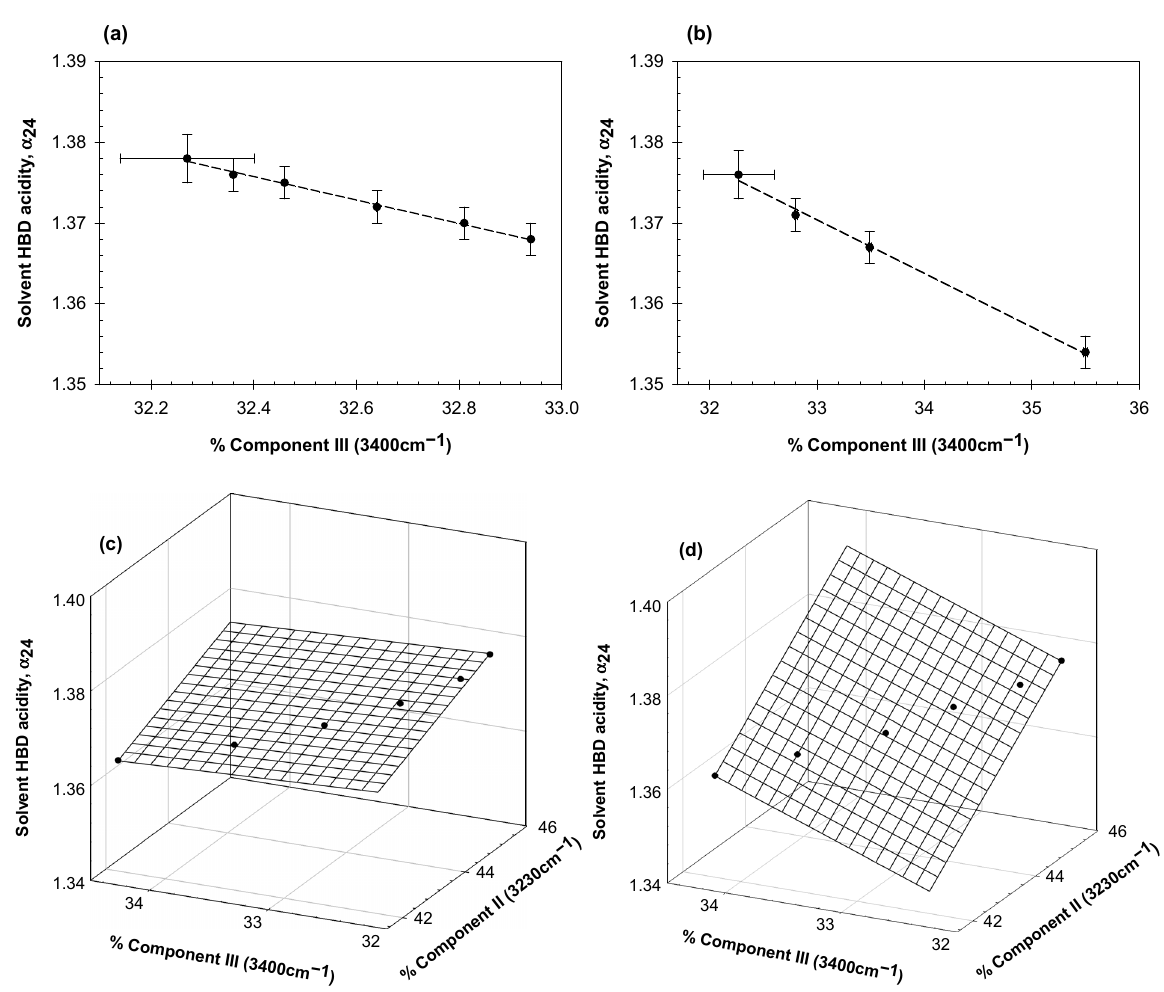
Figure 4. Relationship between the solvent hydrogen bond donor acidity, α 24 , and the relative contributions of Gaussian component III for ( a ) lysozyme and ( b ) bovine serum albumin, and the relative contributions of Gaussian components II and III for ( c ) human serum albumin and ( d ) ovalbumin.